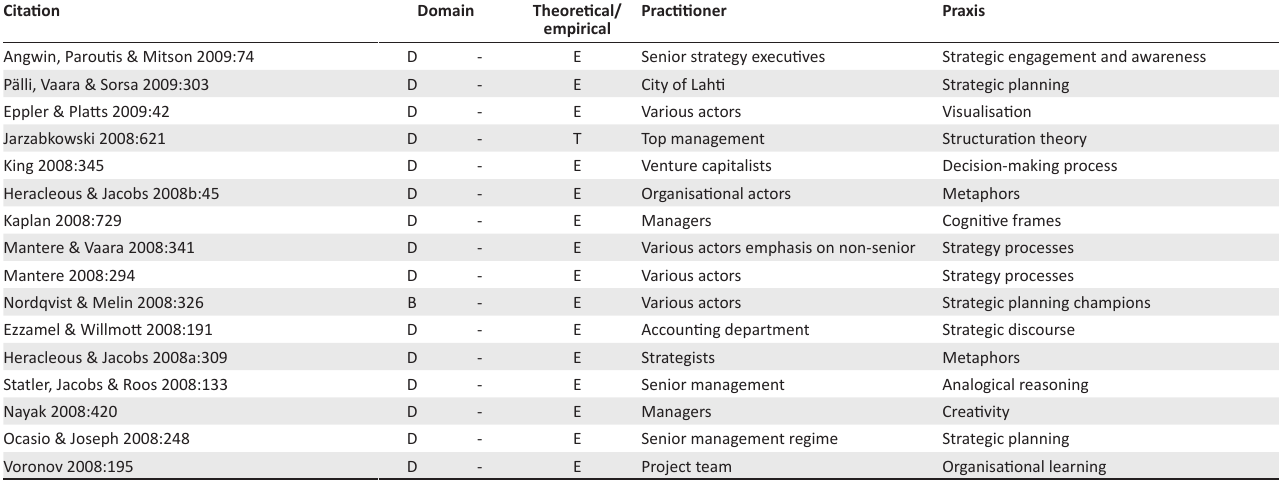
TABLE 1 (Continues...): List of works counted in updated strategy–as–practice typology matrix. Citation